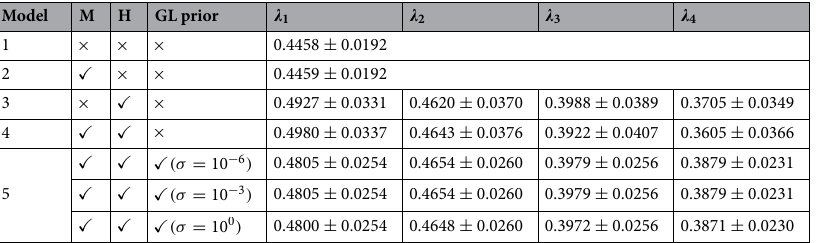
four provinces case are reported in Table 3. It can be observed that models allowing heterogeneity estimate parameters more accurately, and Model 5 that integrates the correlation leads to slightly better estimate for (cid:31) 2 . We can see that compared to Model 4, the estimates of smaller (cid:31) k ’s (such as (cid:31) 2 , (cid:31) 3 , (cid:31) 4 ) become larger, and the